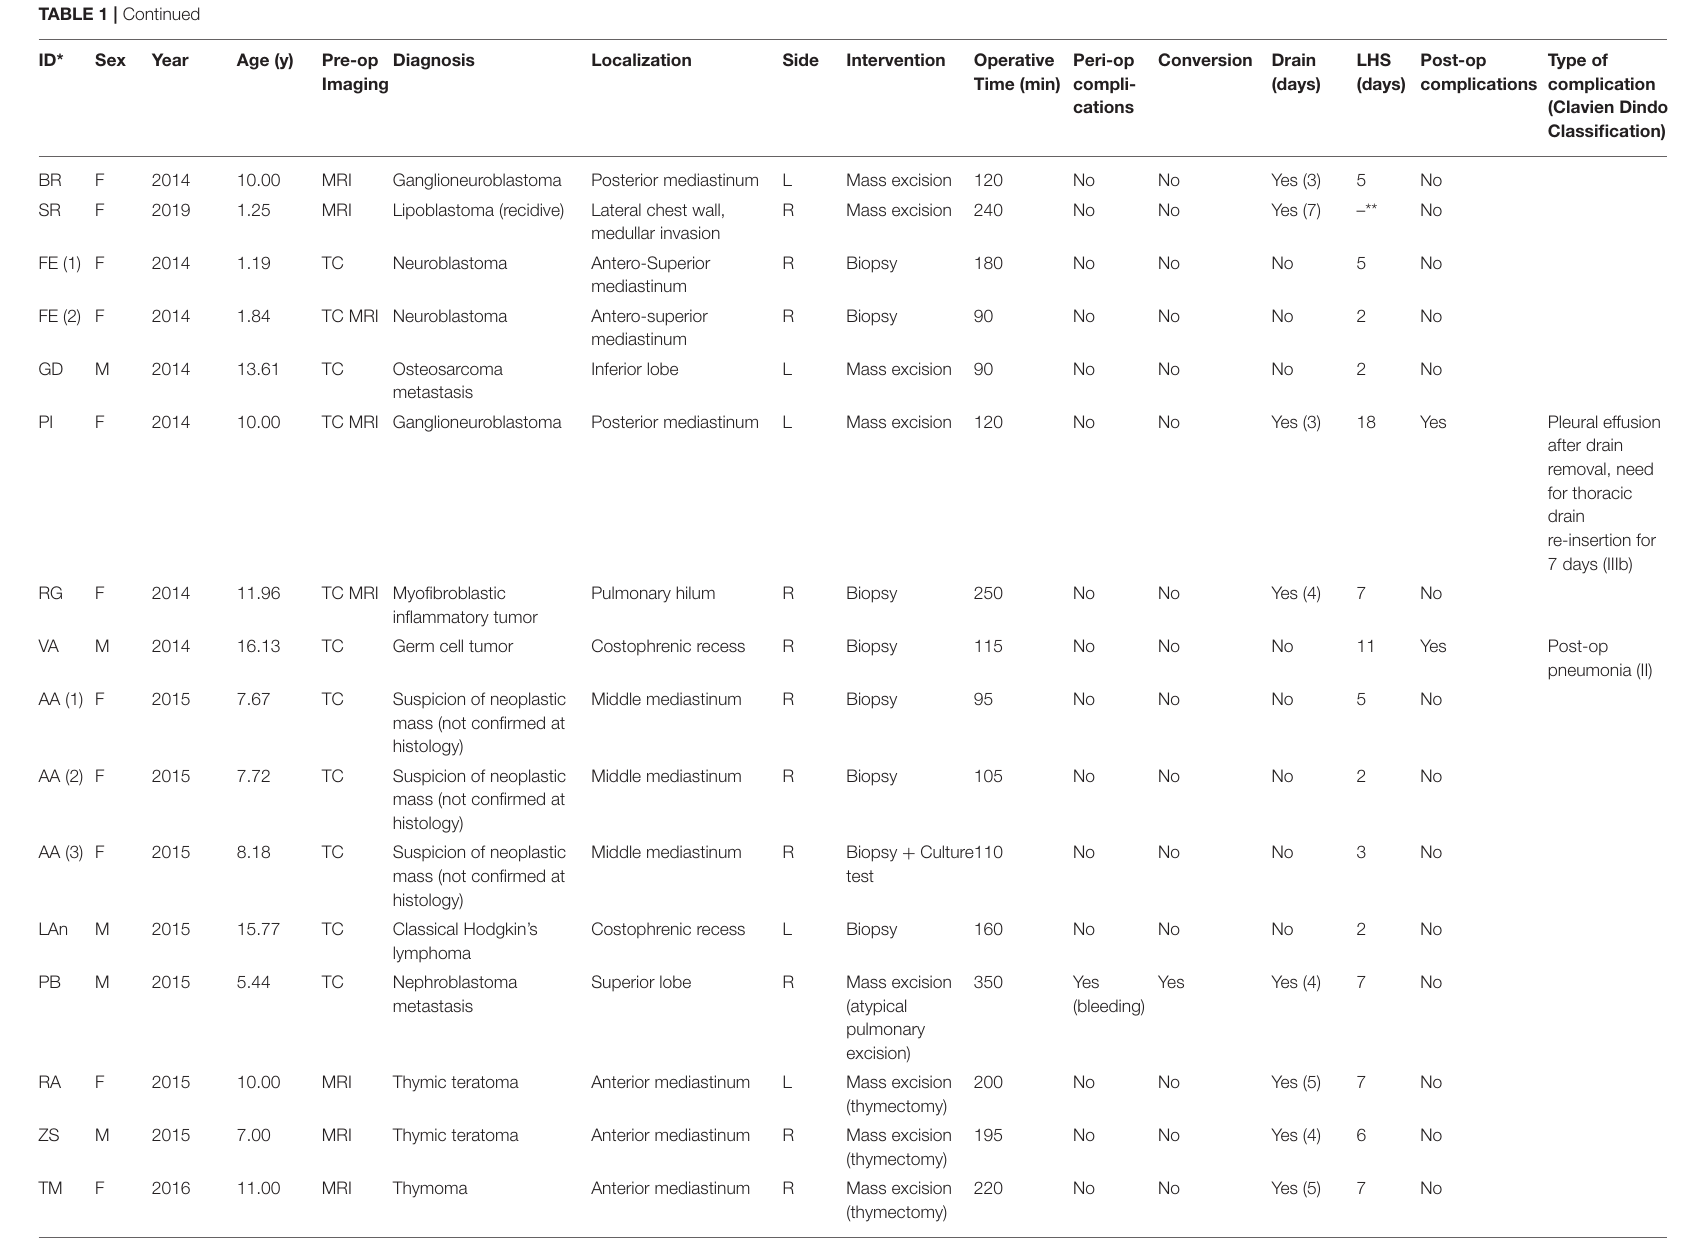
Nephroblastoma metastasis